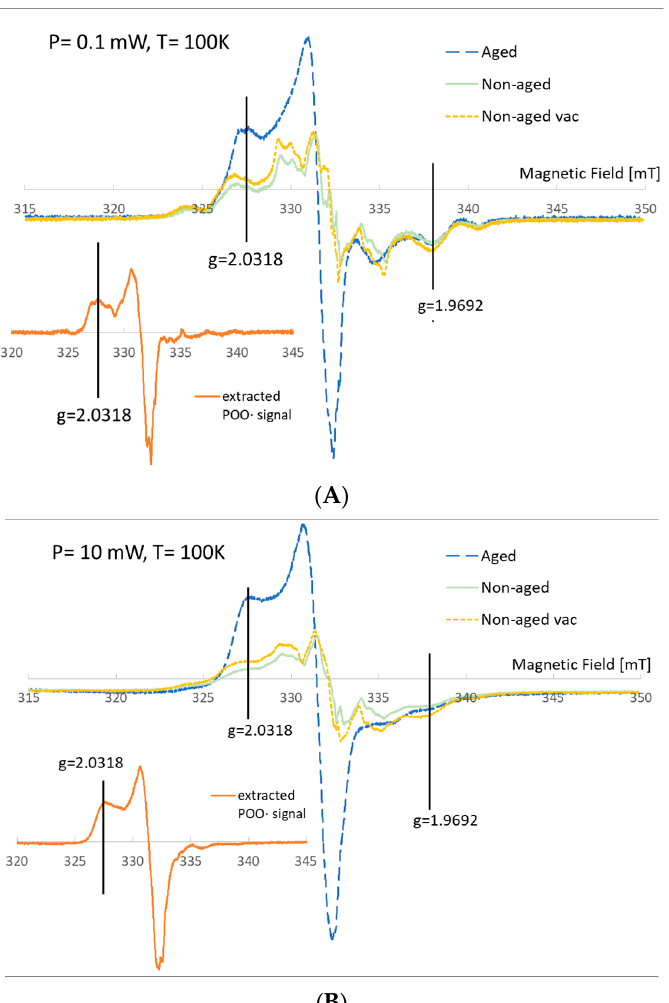
Figure 3. Comparison of low-power (0.1 mW, A ) and high-power (10 mW, B ) spectra of the non- protected, unaged polyethylene, probe-irradiated in vacuum (vac) and an air atmosphere (air), with the spectra of the aged samples (52kGy, low-rate), registered in 100 K. Insets: extracted spectra